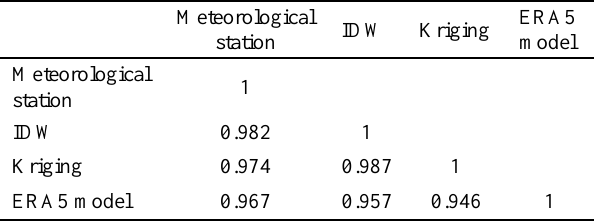
Table 3. Station data, ERA5 model, the correlation